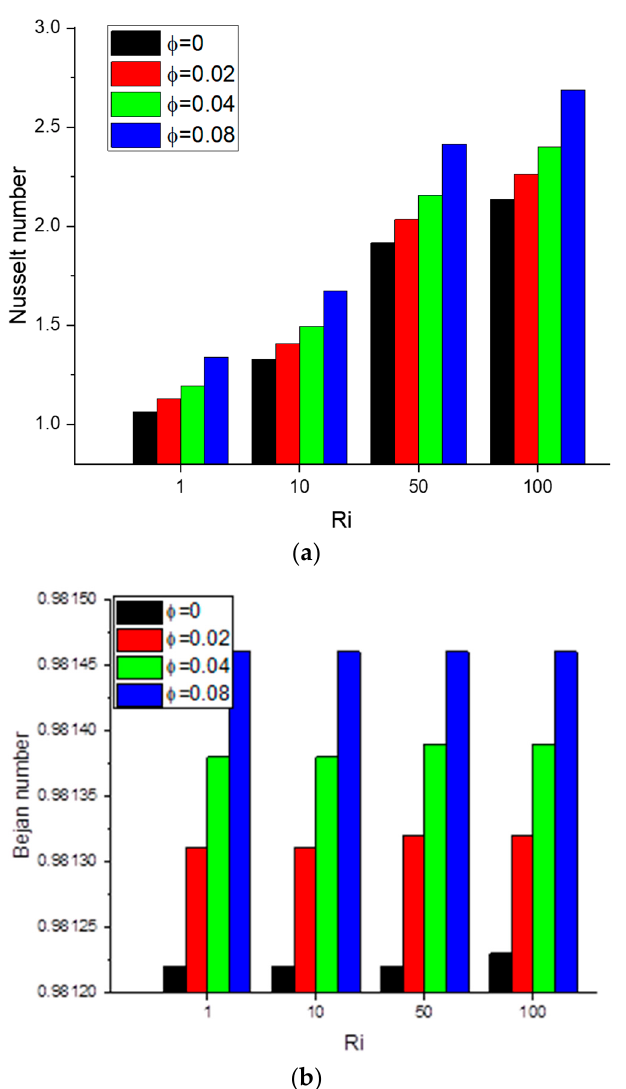
Figure 10. ( a ) Nusselt number: γ : 0°; N = 4; Ha = 0; Ri = 1, 10, 50, 100; φ = 0, 0.02, 0.04, 0.08; ( b ) Bejan number: γ : 0°; N = 4; Ha = 0; Ri = 1, 10, 50, 100; φ = 0.02, 0.04, 0.08.